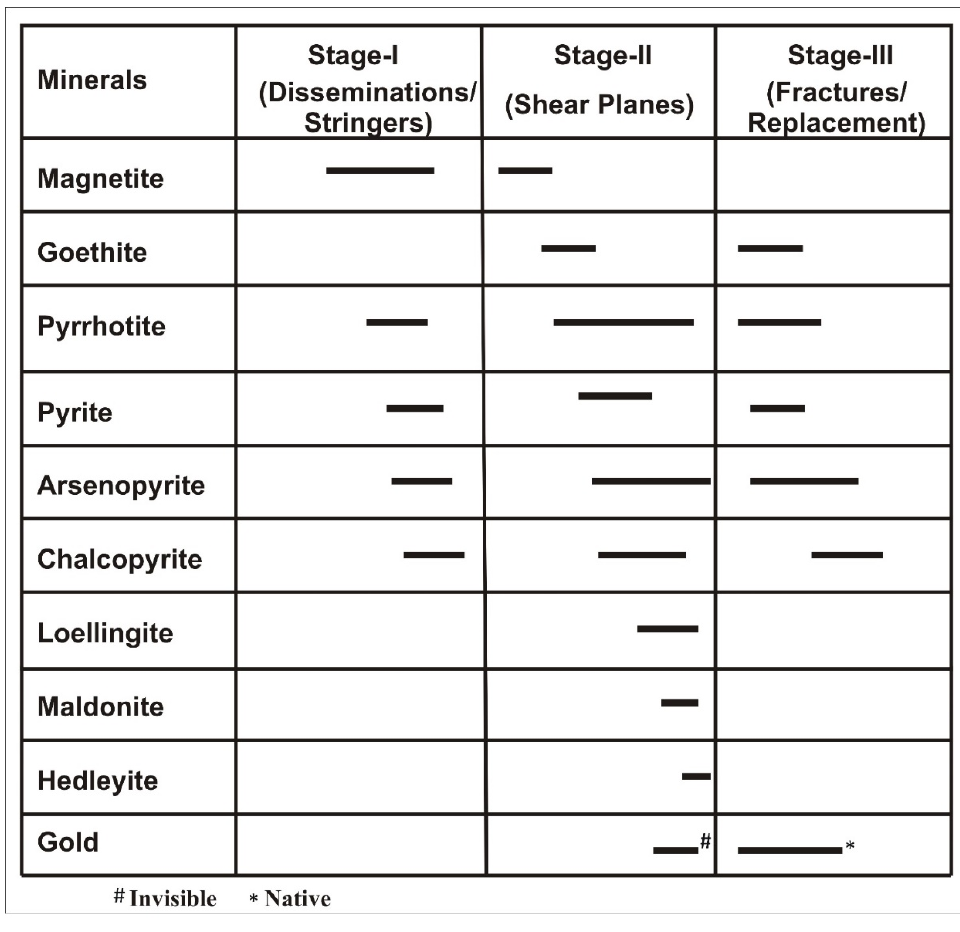
Figure 10. Paragenetic sequence showing evolution of gold mineralization with respect to various oxide and sulfide minerals based on relationships between host rock mineral assemblages, ore textural and micro-structural relationships.